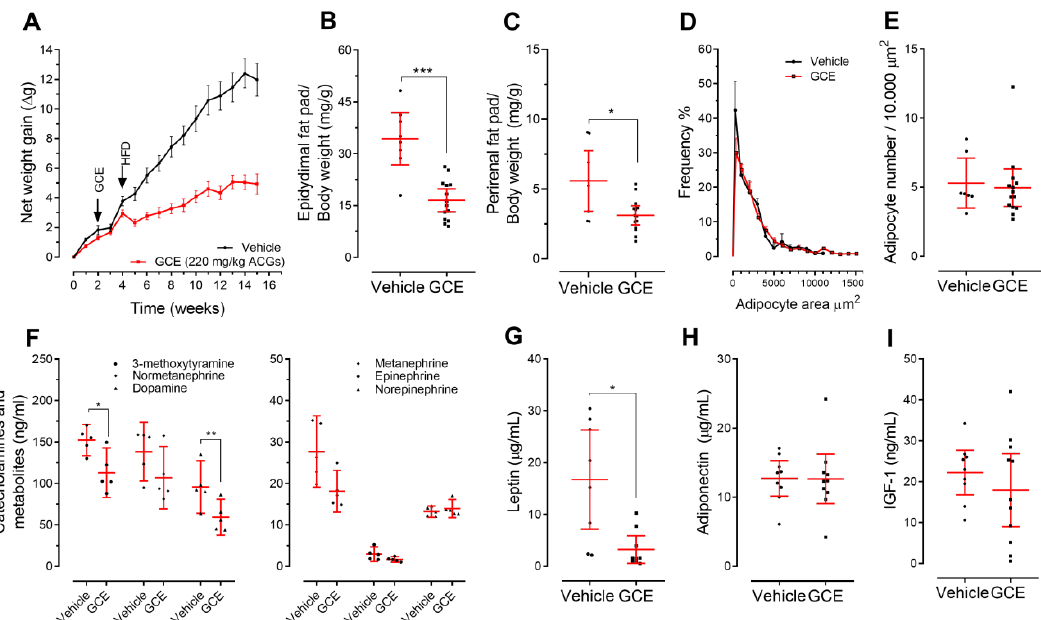
Figure 3. Green coffee extract (GCE) modulates body weight gain and reduces adiposity in ApoE -/- high-fat diet-fed mice. The weights of the mice were recorded weekly for 16 weeks. ( A ) The average net weight gain per treatment is presented as the mean ± SEM. ( B ) Epididymal and ( C ) perirenal fat pad weights were normalized against total body weight. ( D ) Adipocyte area and ( E ) adipocyte number were quantified in epididymal fat sections. ( F ) Urinary levels of catecholamines and metanephrines were determined by high performance liquid chromatography–mass spectrometry (HPLC-MS). Serum levels of ( G ) leptin, ( H ) adiponectin and ( I ) Insulin-like growth factor 1 (IGF-1) were measured by enzyme-linked immunosorbent assay (ELISA). The results are shown as the mean ± 95% confidence intervals, and p -values from unpaired two-tailed t-tests are expressed as follows: * p < 0.05; ** p < 0.01; *** p < 0.001.